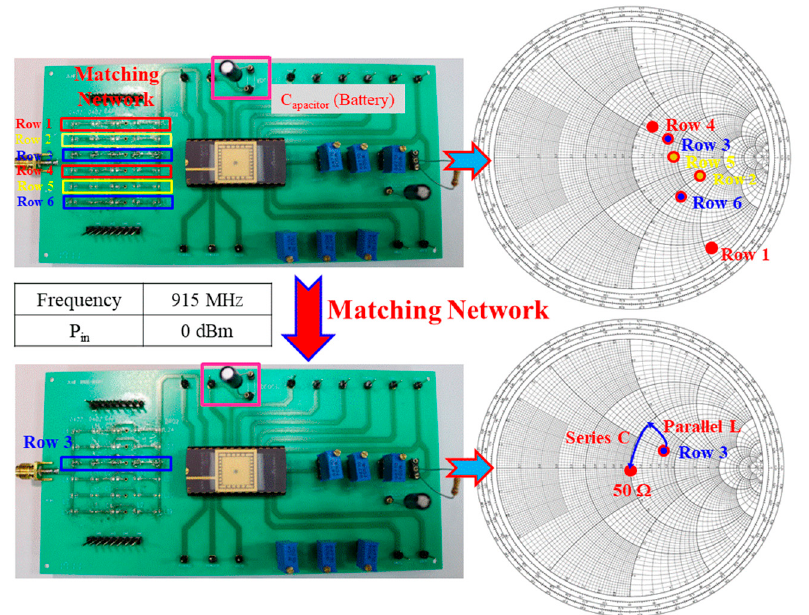
Figure 17. Matching network used to obtain an input impedance of approximately 50 Ω .